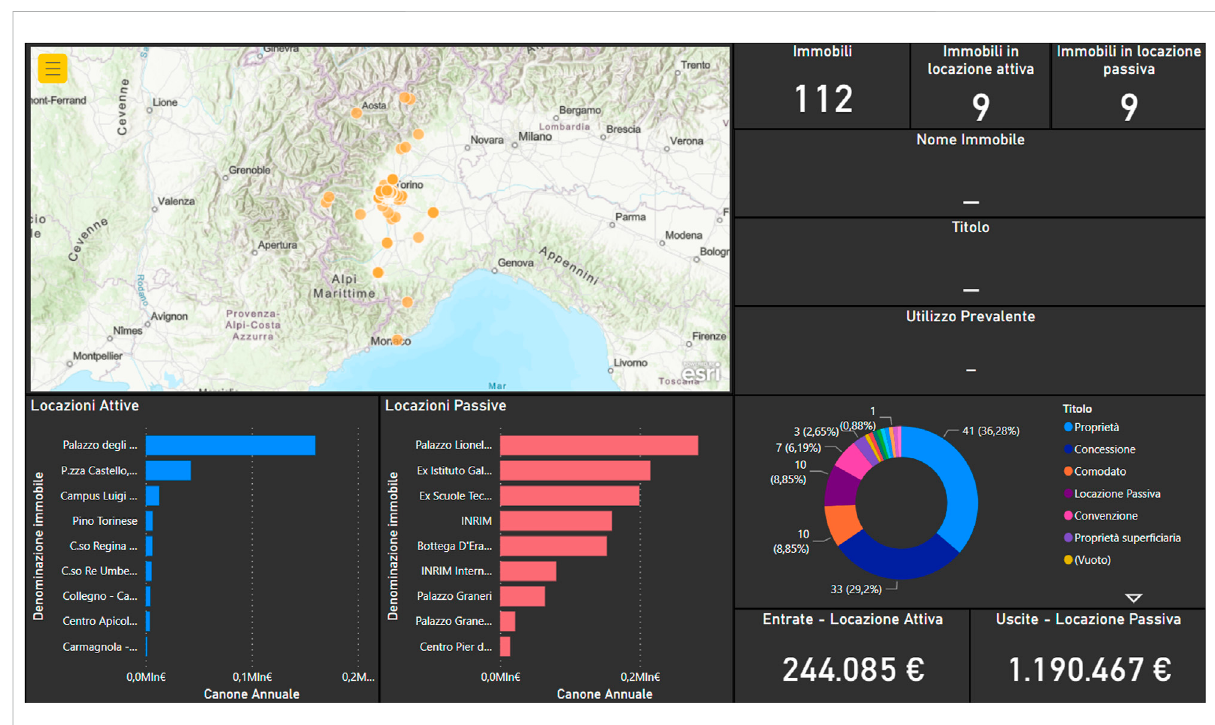
FIGURE 8 Overall analytic dashboard of UniTO asset distribution and destinations, with related expenses.